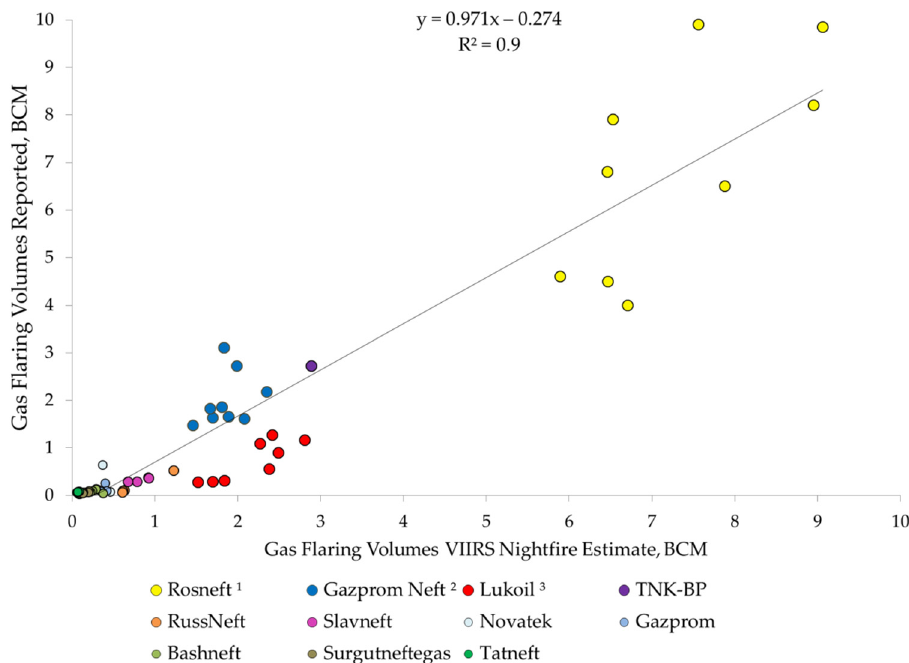
Figure 8. Scatterplot VIIRS Nightfire estimates (BCM) vs. reported gas flaring volumes (BCM) by the major oil and gas companies in Russia available in their annual reports or reports on sustainable development (directly or as a result of APG extraction volumes and gas utilization rate) in 2012–2020. Note that both Nightfire and reported data include only oil upstream facilities. 1 The Rosneft reported data and the VIIRS Nightfire data include TNK-BP and Slavneft assets starting in 2013 and Bashneft in 2016. The Rosneft data include shares in joint ventures. 2 The Gazprom Neft reported data and the VIIRS Nightfire data exclude shares in joint ventures. 3 Due to the event described in Section 4.1, Lukoil’s 2016 data are excluded from the graph.